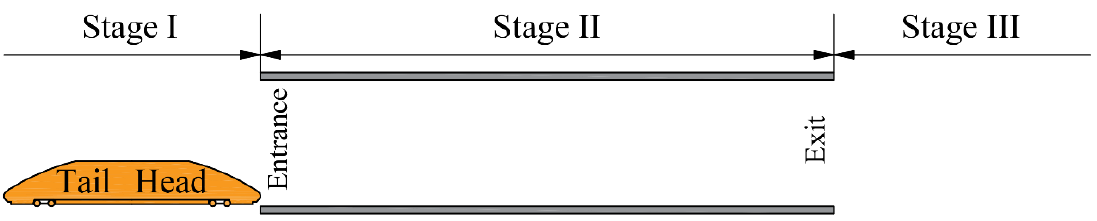
Figure 10. Spatial relationship between train and tunnel.